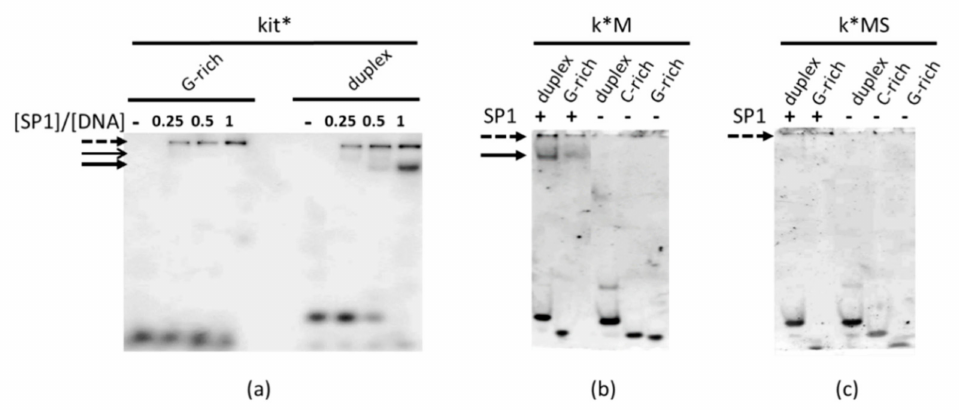
Figure 3. Electrophoretic mobility shift assay (EMSA) of 100 nM kit* ( a ) and related mutants (k*M ( b ) and k*MS ( c )) in the presence of 0.25, 0.5 or 1 eq of SP1. Lanes labelled—refer to samples in the absence of protein; solid arrows point to DNA-protein complexes, the dotted one to not solved high molecular weight species.